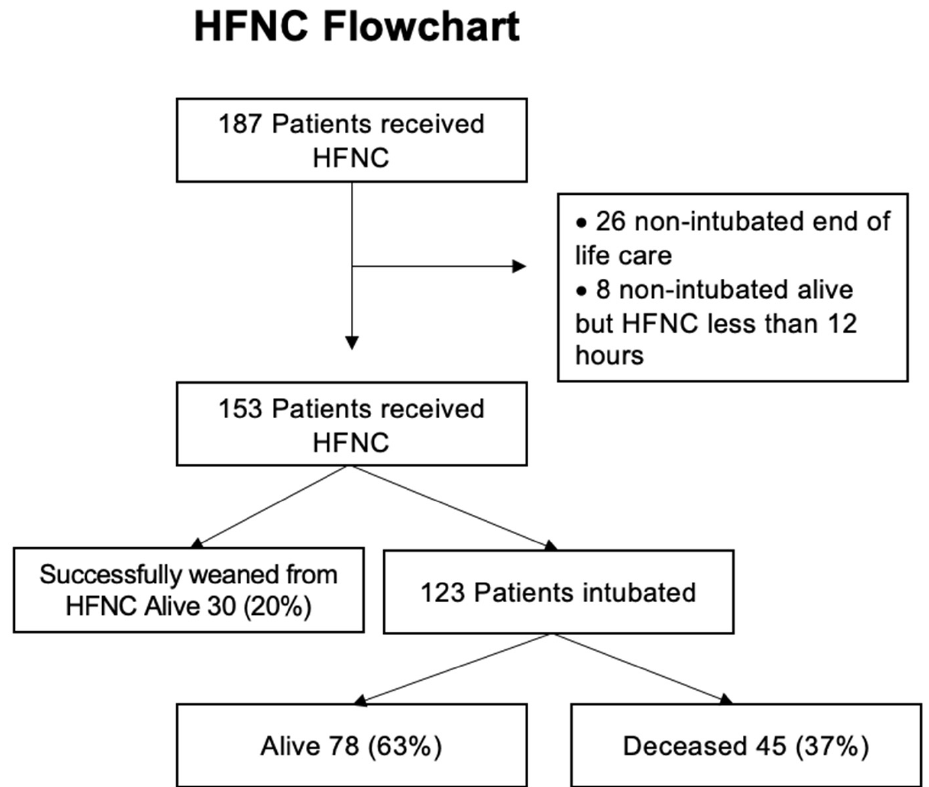
Figure 1. Flow chart. HFNC = High-flow nasal cannula.